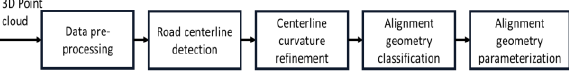
Figure 3. Road alignment parameterization